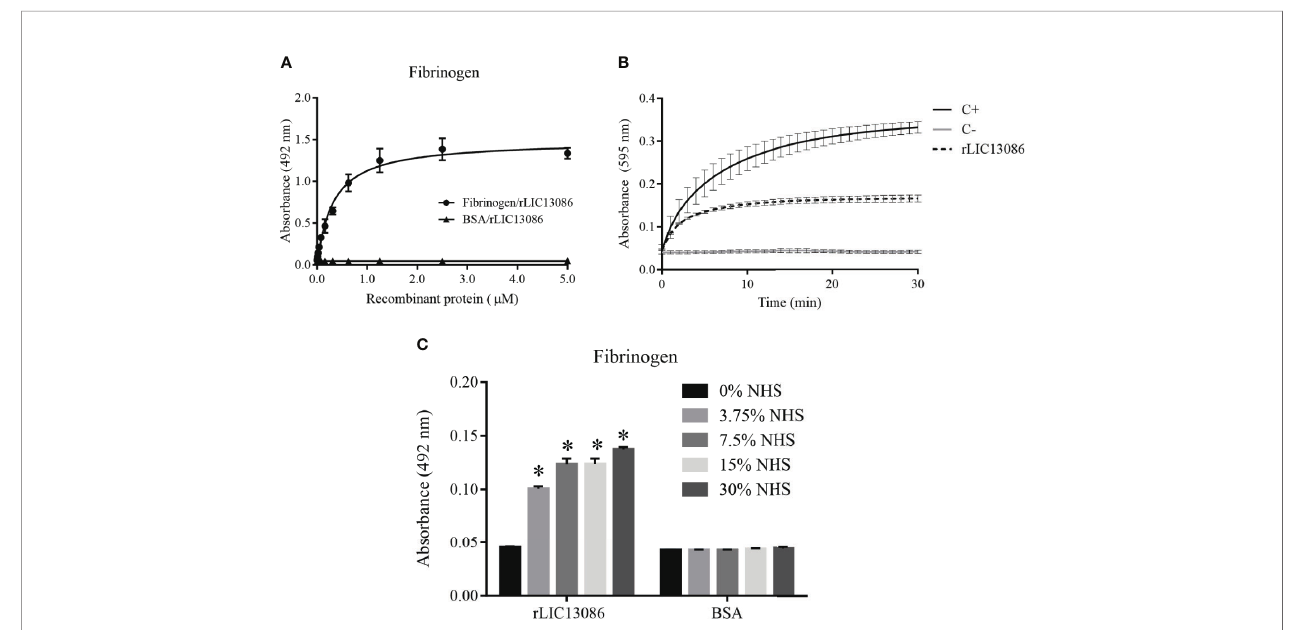
FIGURE 7 | Characterization of rLIC13086 interaction with fi brinogen. (A) Coated fi brinogen (1 m g) was incubated with different concentrations of rLIC13086 (0 – 5 m M) for 2 h at 37°C and detected with HRP-conjugated anti-HisTag mAb (1:10,000). (B) rLIC13086 was incubated with human fi brinogen for 2 h at 37°C, thrombin was added, and fi brin clot formation was recorded for 30 min by measuring absorbance at 595 nm. C+: Positive control with only fi brinogen and thrombin; C − : Negative control without fi brinogen. (C) rLIC13086 was immobilized and incubated with increasing concentrations of NHS. The interaction was assessed by the addition of goat anti-human fi brinogen (1:10,000) followed by HRP-conjugated anti-goat IgG (1:50,000). BSA was used as negative control. The bars represent the means of three different experiments in triplicates with the corresponding standard deviation. * Indicates signi fi cant difference calculated by Student t- test with p-values <